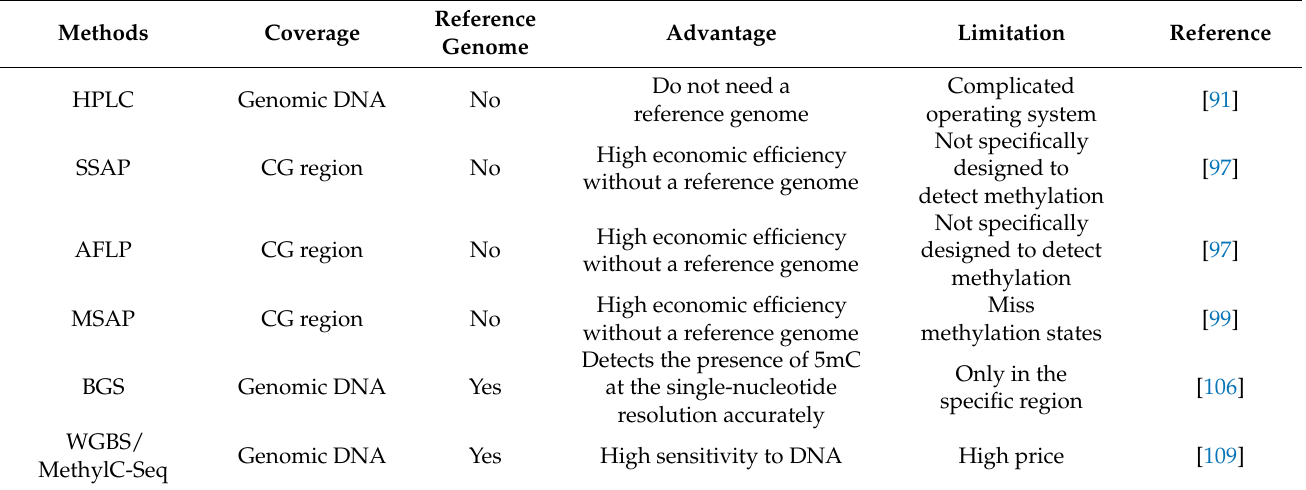
Table 2. Methodology of plant DNA